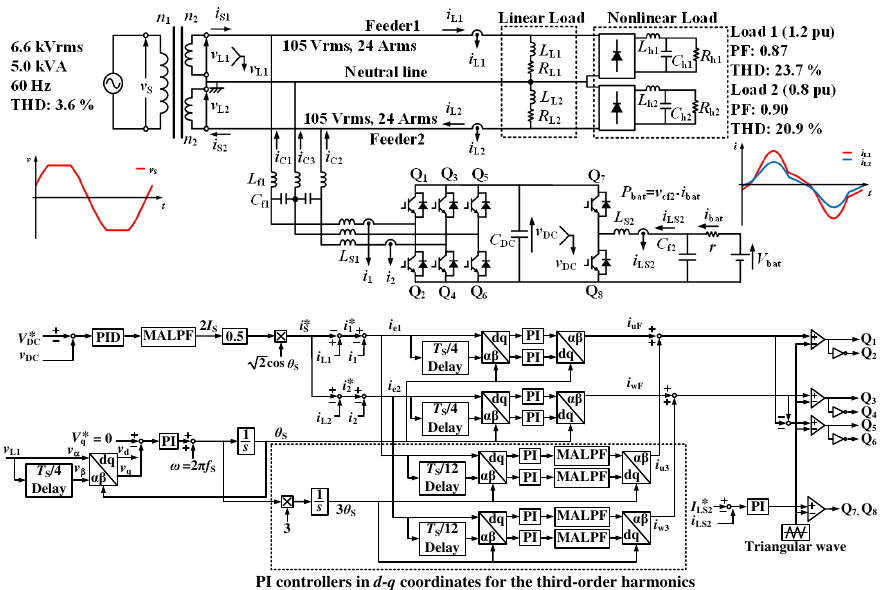
Figure 1. Power circuit diagram with control circuit of bidirectional battery charger (BBC) for electric vehicles (EVs) in single-phase three-wire distribution feeders under distorted source-voltage and load-current